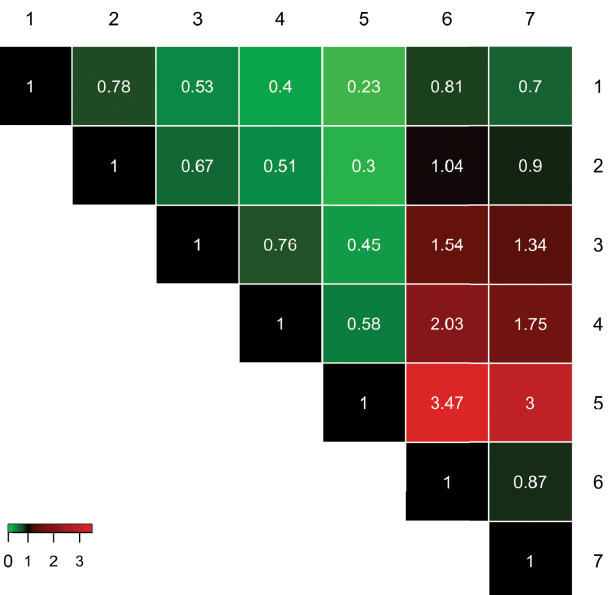
Fig 4. Heat map showing the pairwise ratio of the residual error estimates for all raters. The residual error estimate for the rater indicated in each row was divided by the rater in each column, and then was displayed as a heat map to highlight similarities and differences between raters. Each ratio is shown as the number inside of the colored box. The brightness of the color indicates relative strength of difference between raters, with red representing a ratio greater than one and green representing a ratio less than